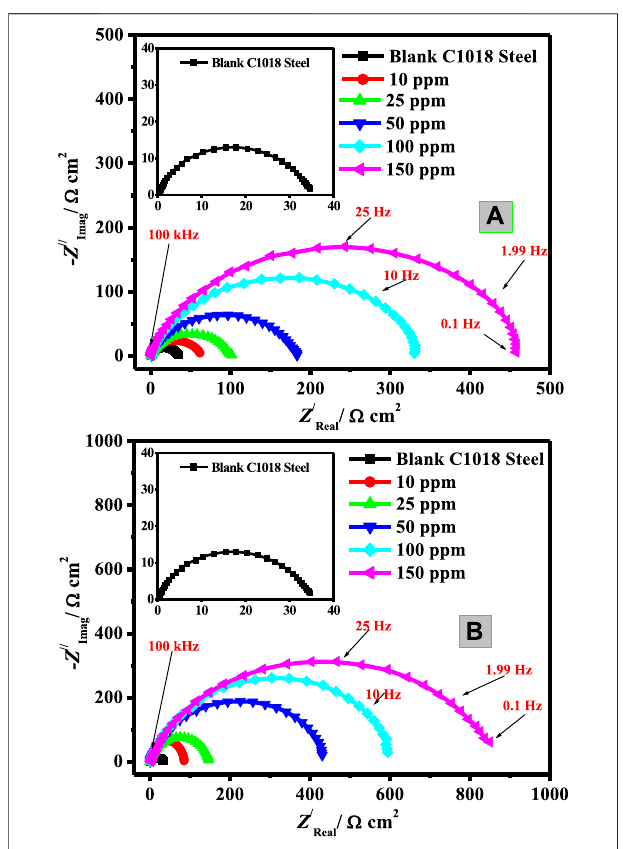
FIGURE 3 | Nyquist plots of C-steel/CO 2 -saturated 3.5% NaCl/ surfactant uninhibited and inhibited by diverse concentration of (A) CSM and (B) CSD at 50 ± 1 °